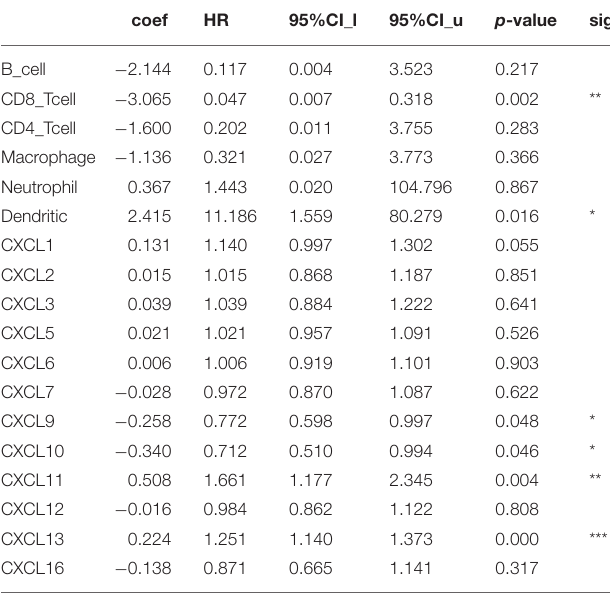
TABLE 4 | The cox proportional hazard model of CXC chemokines and six tumor-infiltrating immune cells in RCC